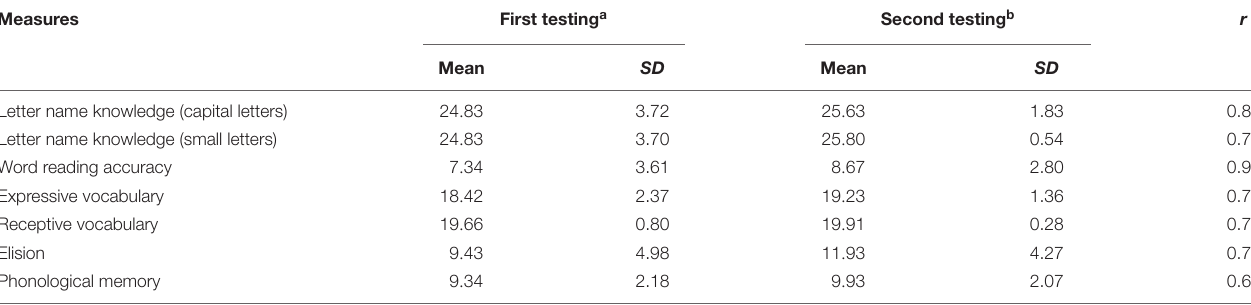
TABLE 3 | Test–retest reliability of untimed measures.